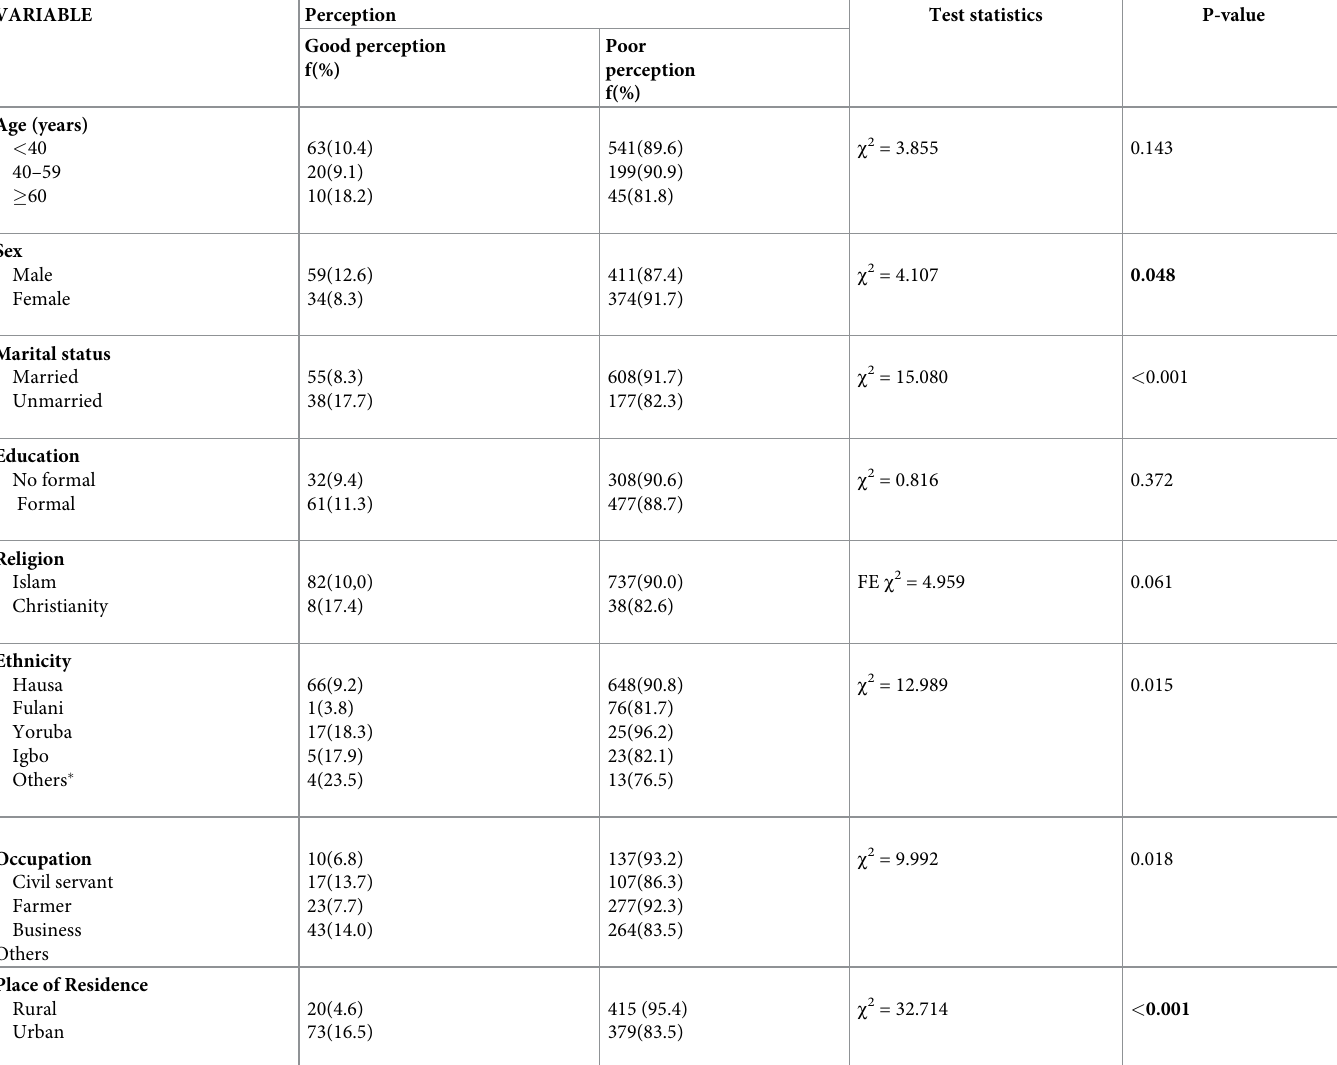
Table 5. Factors influencing the perception of respondents regarding the COVID-19